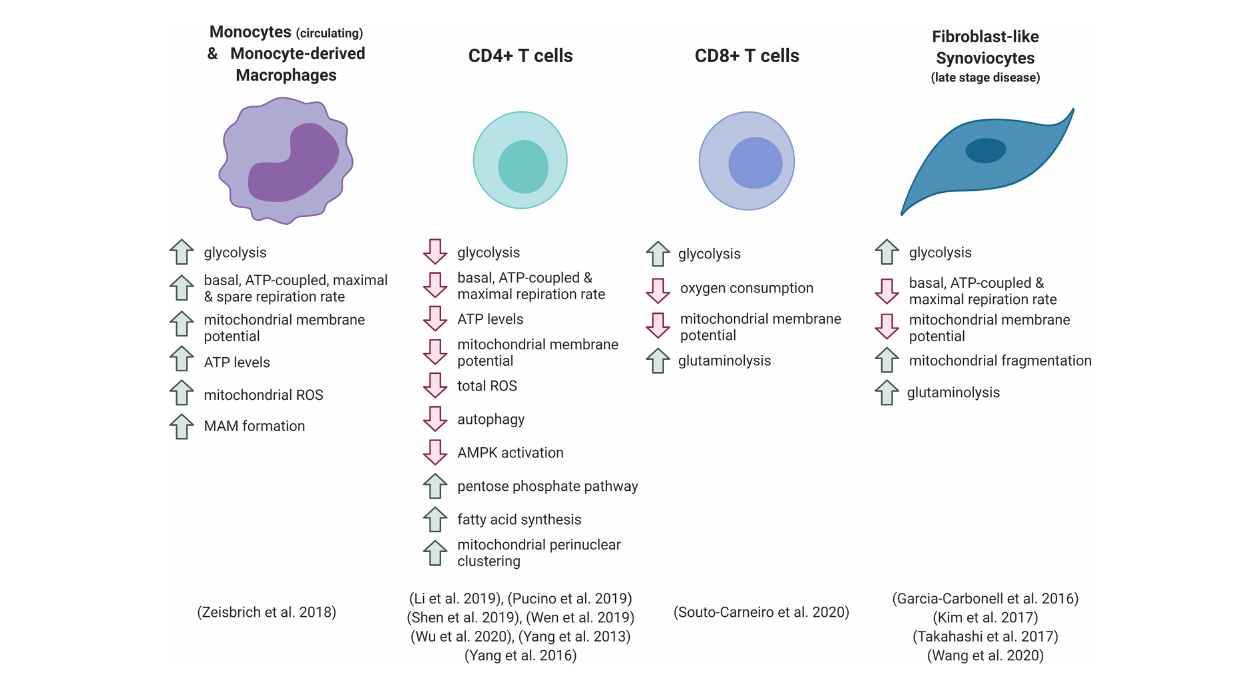
FIGURE 1 | Metabolic phenotype of different cell types in rheumatoid arthritis. ROS, reactive oxygen species; MAM, mitochondria-associated